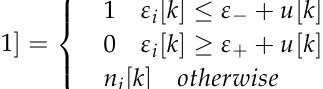
Figure 10. Energy trajectory of a single demand side electrolyzers for ( a ) the uncontrolled case; ( b ) the uncontrolled case in the magnified time range; ( c ) the controlled case; and ( d ) the controlled case in the magnified time range.